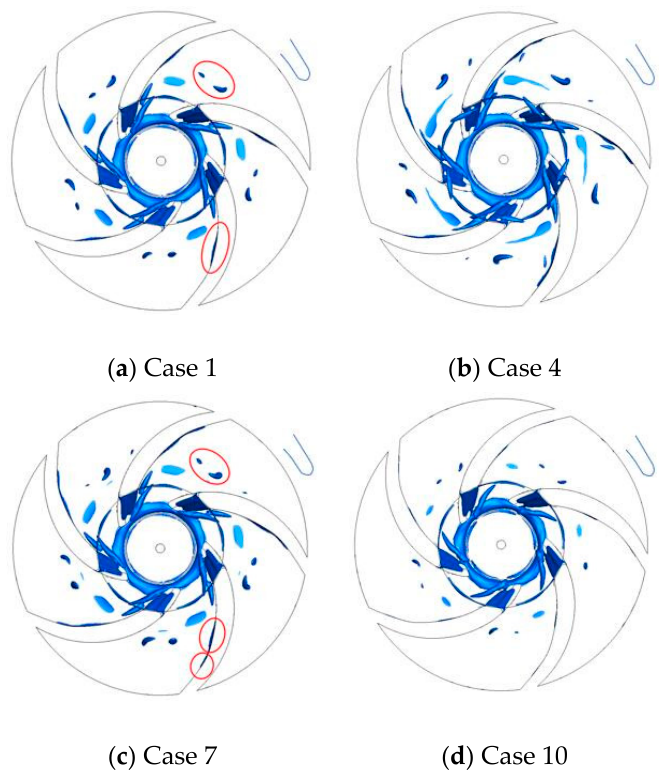
Figure 15. Distribution of the Q T values for ( a ) Case 1, ( b ) Case 4, ( c ) Case 7, and ( d ) Case 10 ( Q T = 1.0 × 10 7